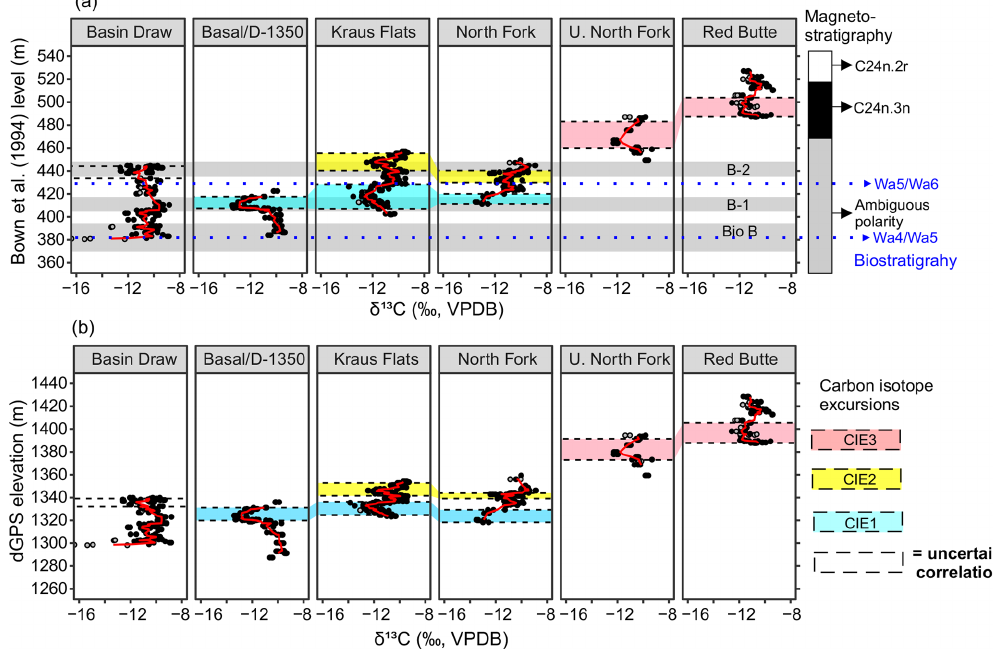
Figure 4. Carbon isotope data for Fifteenmile Creek sections shown using the (a) Bown et al. (1994) equivalent meter level and (b) differ- ential GPS elevation. The stratigraphically lowest, middle, and highest carbon isotope excursions are outlined by the blue, yellow, and red shading, respectively. The stratigraphic intervals associated with the faunal events described in Chew (2015) are shown as grey shaded regions in the top panel, along with faunal zone boundaries (blue dotted lines) based on Bown et al. (1994). Magnetostratigraphy is based on Clyde et al. (2007), partly reinterpreted from Tauxe et al. (1994). Points represent measurements for individual nodules (black: δ 18 O > − 11 . 7‰, grey: δ 18 O < − 11 . 7‰). Red lines are a three-point moving average through the mean values from a sampling